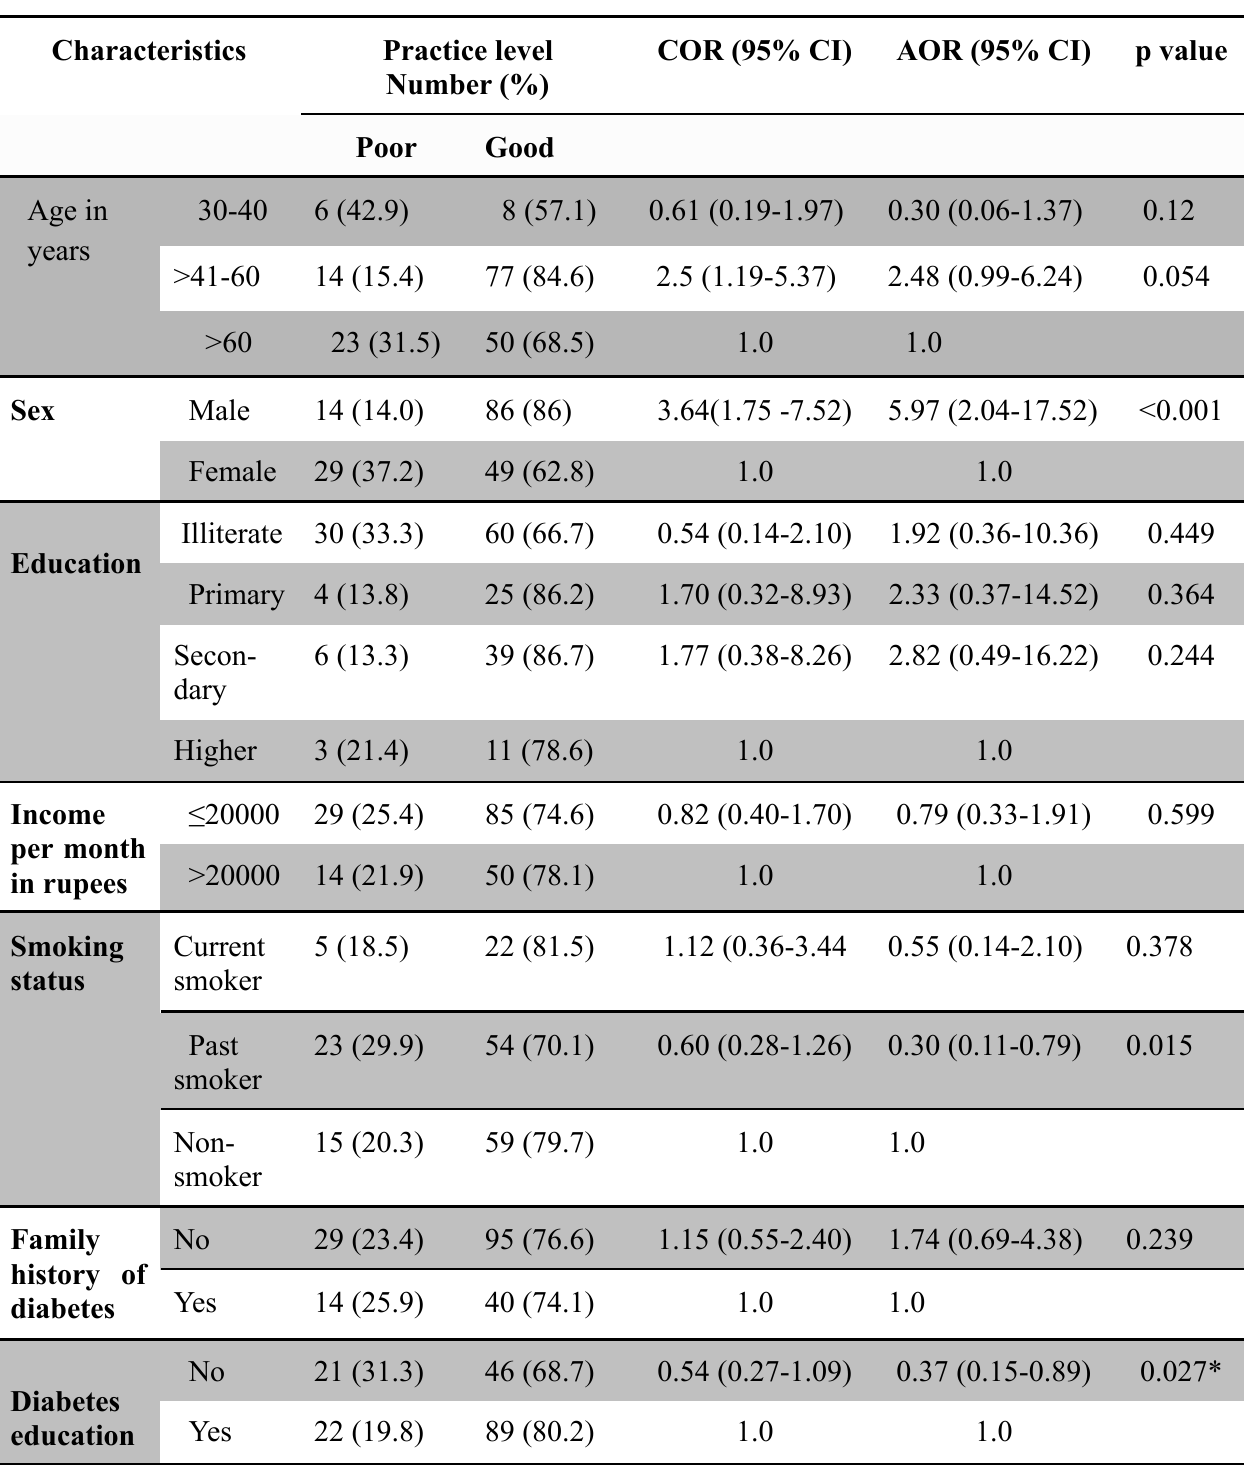
Table 5 Factors associated with foot care practices among the participants (n=178)